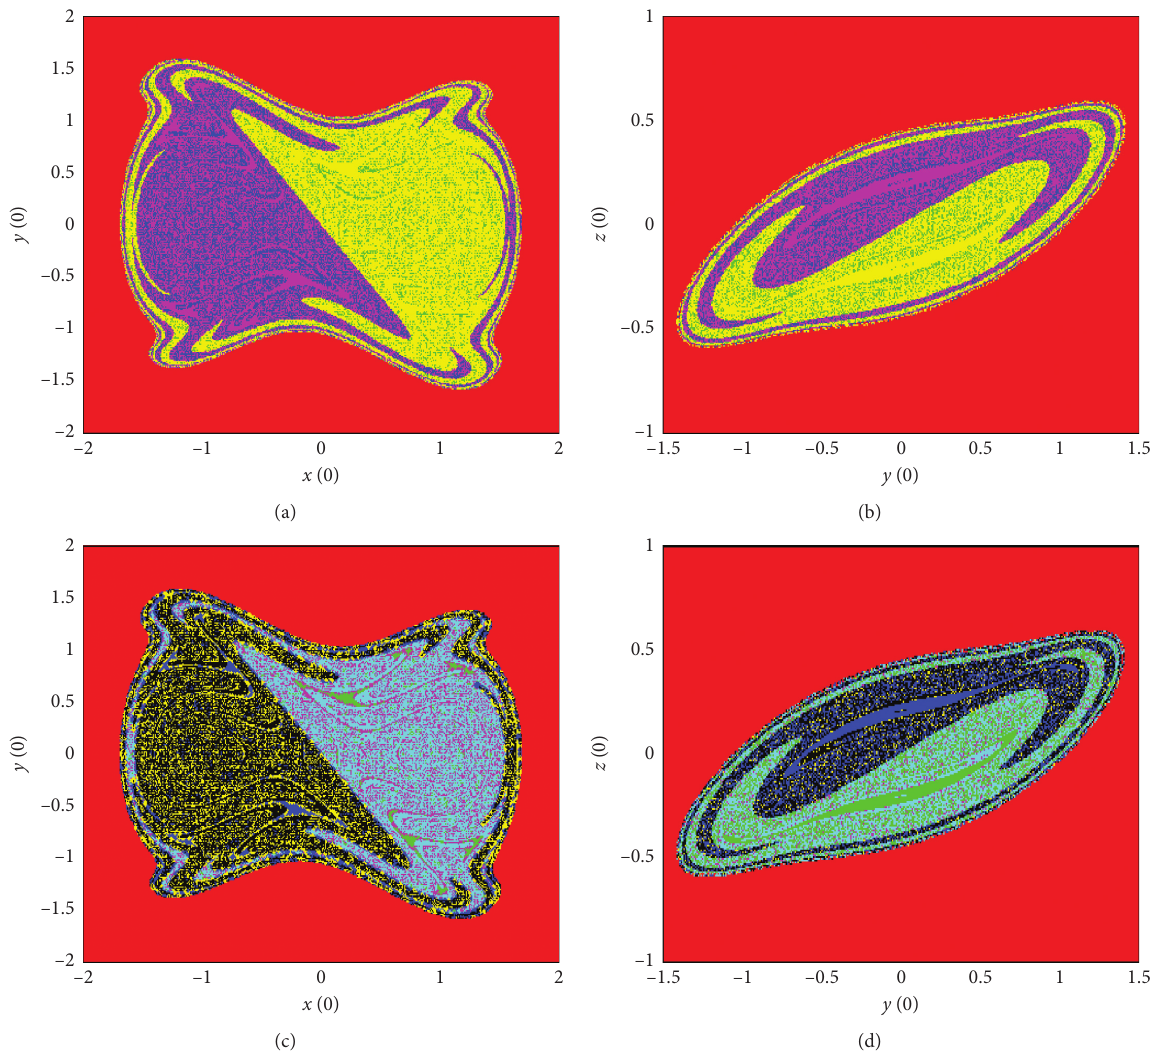
Figure 12: Cross sections of the basins of attraction in the ( x ( 0 ) − y ( 0 )) and ( y ( 0 ) − z ( 0 )) plane: on (a, b) blue and yellow colors indicate regions of period-1 while green and magenta indicate regions of chaotic attractors; on (c, d) magenta and yellow colors indicate the regions of n-finite periods, cyan and black indicate the regions of period-6 while green and blue the regions indicate of period-1. Regions of unbounded behavior are in